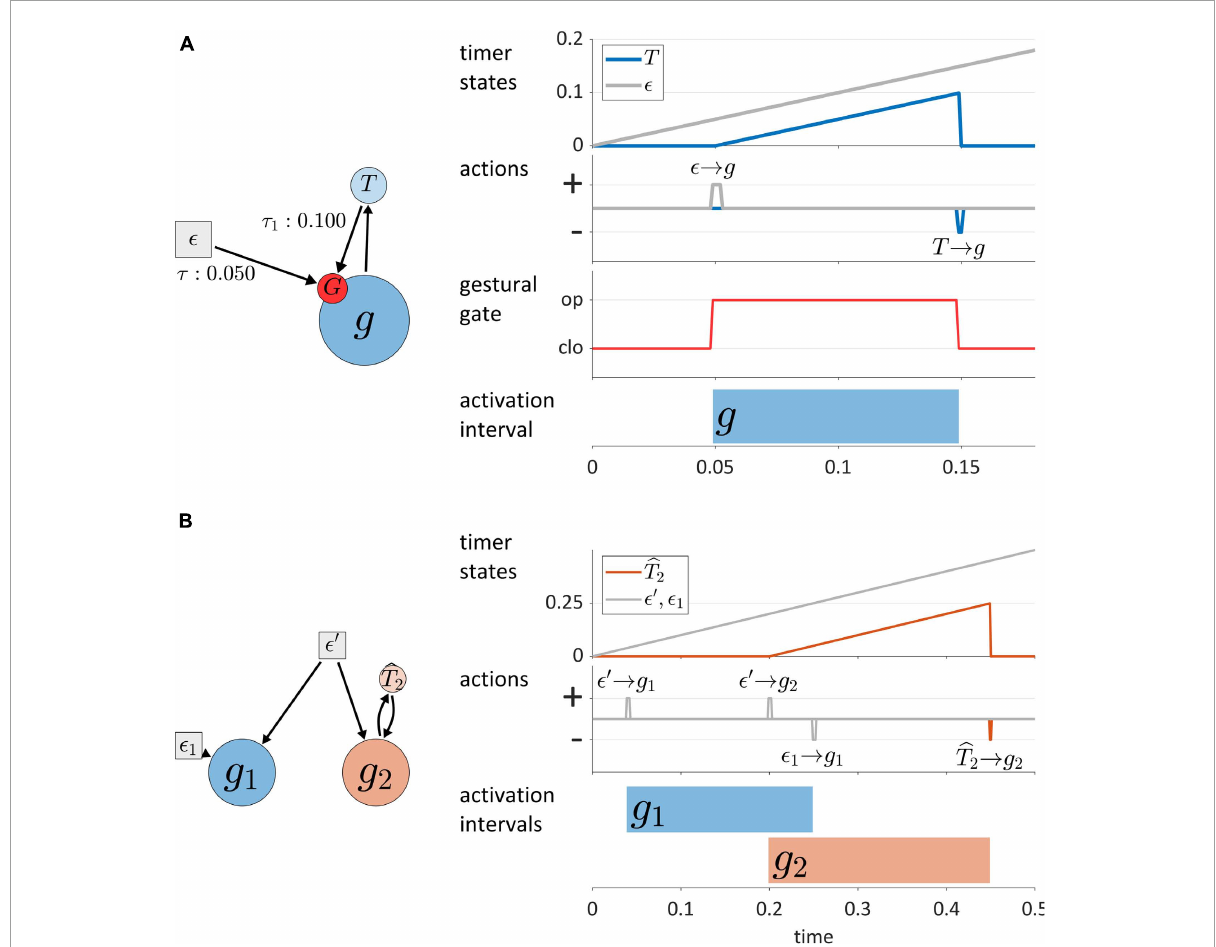
FIGURE5 (A) Model of interactions between gestures and TiRs, with depiction of the gestural gating system G that TiRs act upon. Panels on the right show timer states, timer actions on gestures, gestural gating system states, and gestural activation interval. (B) Distinction between autonomous TiRs ( (cid:15) (cid:48) , (cid:15) 1 ) and non-autonomous TiRs ( b T 2